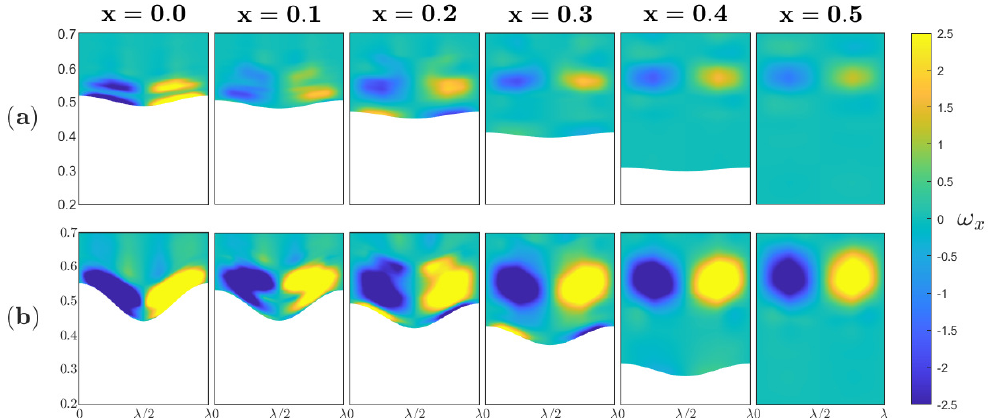
Figure 16. Contours of mean streamwise vorticity ω x over the y – z plane for the wavy models, A03 ( a ) and A11 ( b ), for increasing values of x . Refer to Figure 14 (right schematic) for the planes and coordinates adopted. As a spanwise periodic phenomenon, the spatial average referring to the repetition of wavelengths is calculated and exhibited here as a single